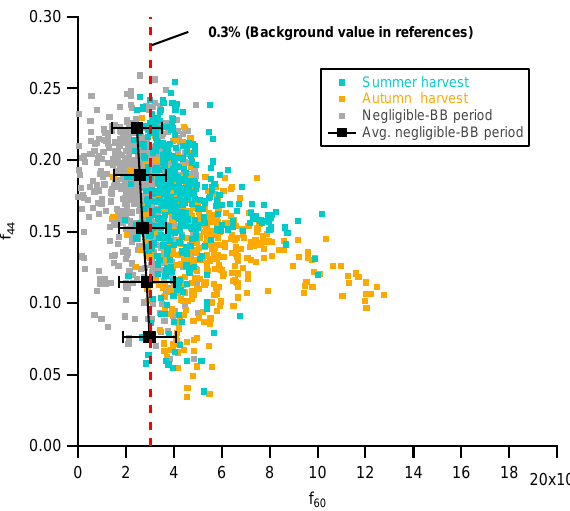
Figure 9. Summary plots showing f 44 vs. f 60 for measurements with little or negligible biomass-burning influence. Colored by the summer harvest (blue), autumn harvest (orange), and a lit- tle/negligible biomass-burning influence period (gray, 1 to 8 July 2013). Also shown is the average background level of f 60 ( ∼ 0.3%, red dashed line) in other studies from Aiken et al. (2009) and Cubi- son et al. (2011) for references.